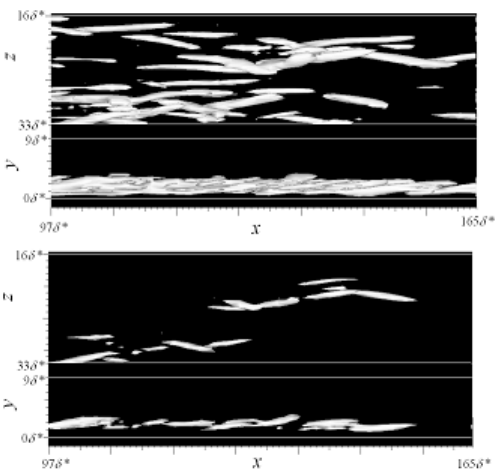
Fig. 6 Turbulent spots visualized by second invariant Q: upper photograph (Q=0.001); lower photograph